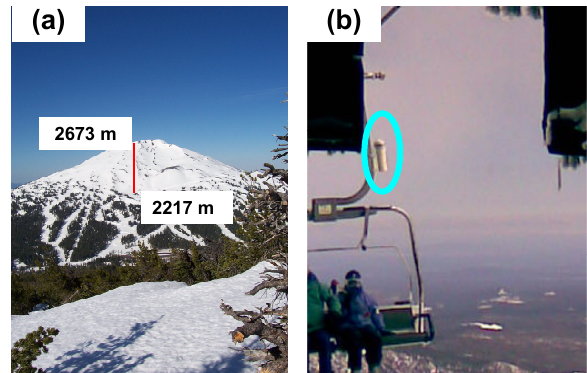
Figure 1. (a) Mt. Bachelor; observatory is at summit, with the chairlift used in the Fig. 1. (a) Mt. Bachelor; observatory is at summit, with the soundings highlighted in red (2217 m up to 2673 m ASL); (b) HOBO MicroStation chairlift used in the soundings highlighted in red (2217m up instrument collecting “chairlift soundings”. to 2673ma.s.l.); (b) HOBO MicroStation instrument collecting “chairlift